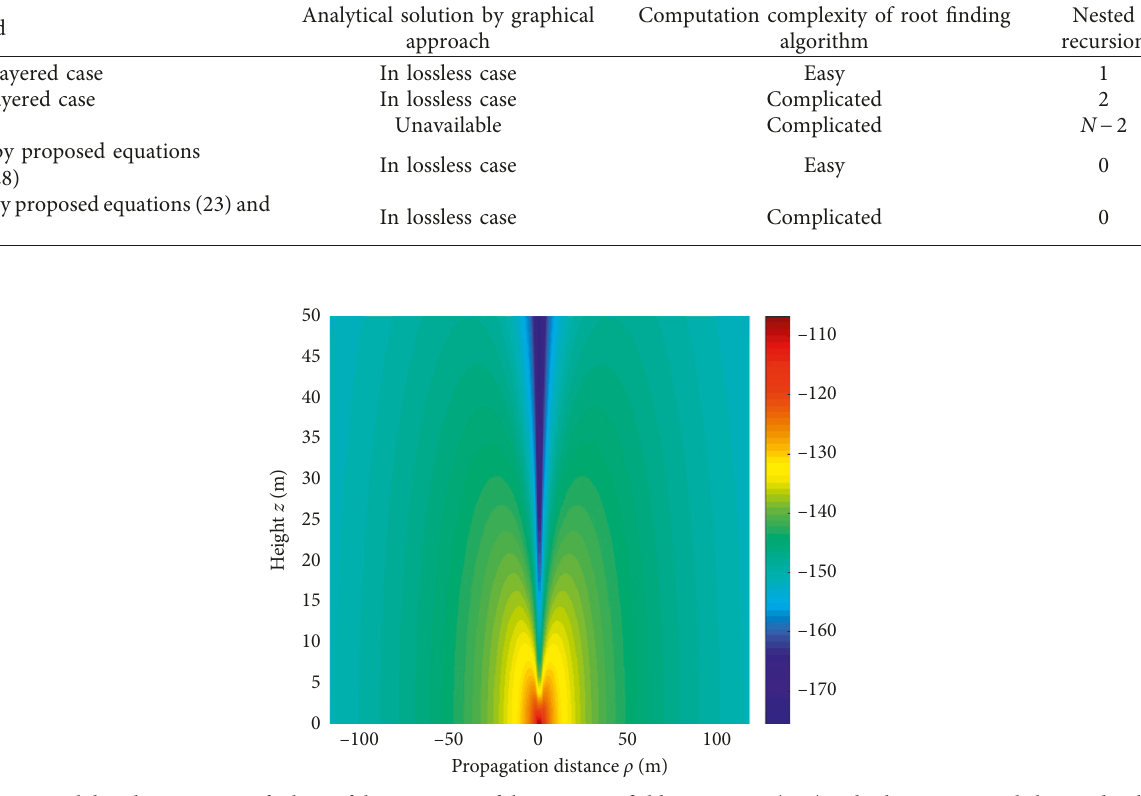
| in dB due to a vertical electric dipole in 0 ϕ